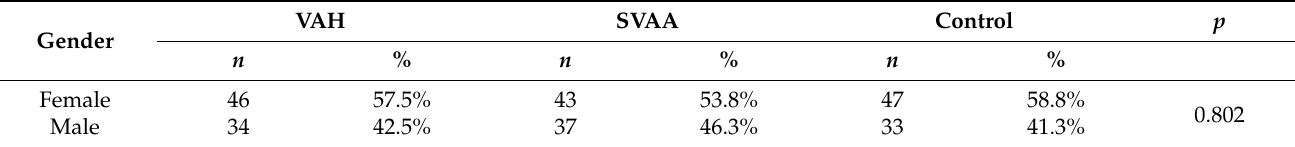
Table 1. Gender structure.